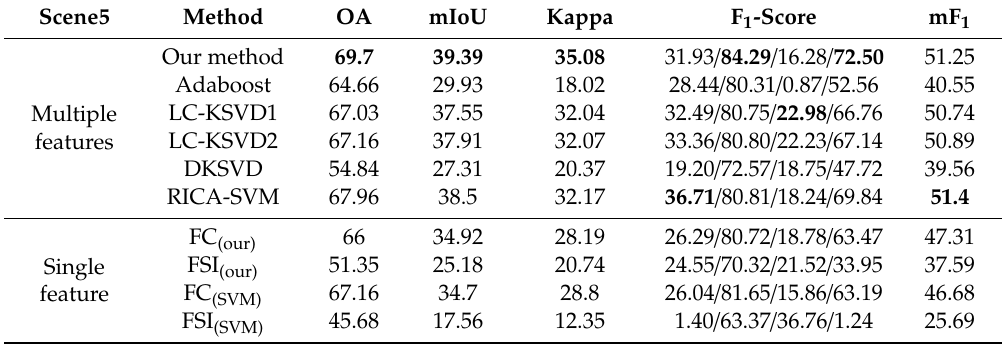
Table 7. Classification results of Scene 5(%). F 1 -score corresponds to the accuracy in terms of pedestrians/trees/cars/buildings. Note that the highest accuracy values are highlighted in